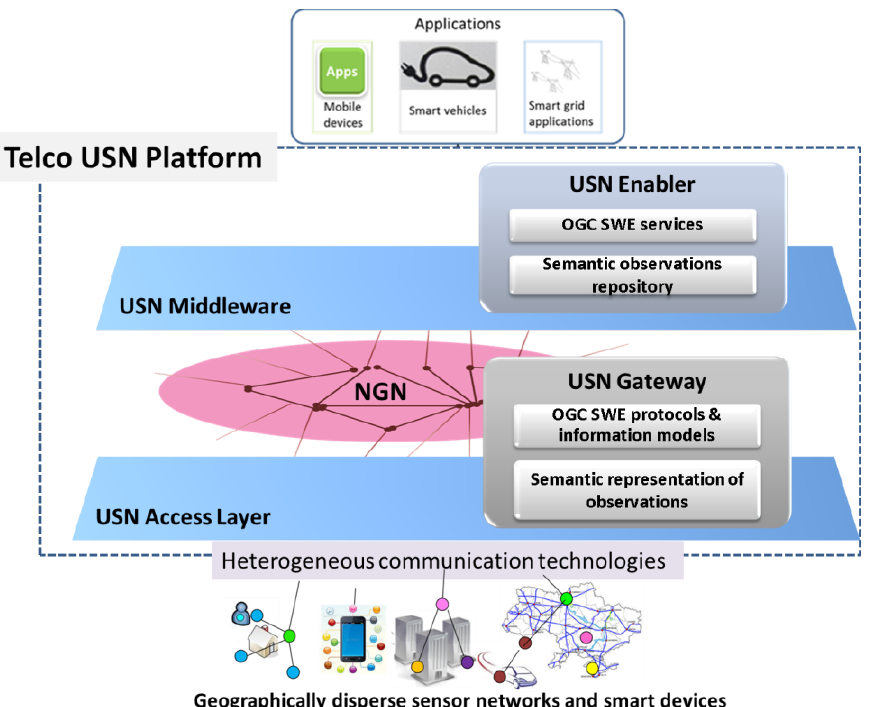
Figure 1. Conceptual architecture of a Ubiquitous Sensor Network Platform to connect applications (e.g., smart devices) with sensor and actuator networks. (Components of the proposed semantic extension are also